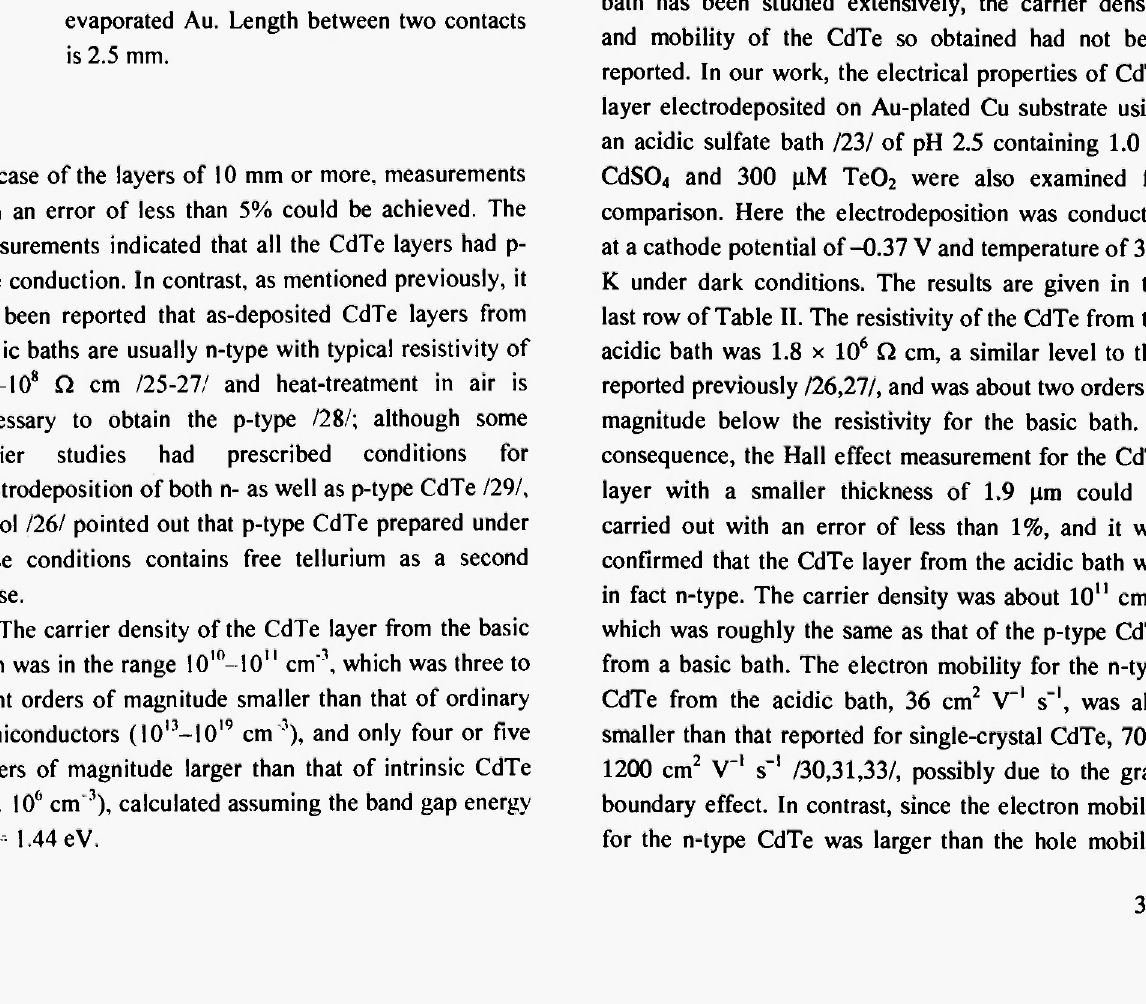
Fig. 12: I-V characteristics for transferred CdTe layers with four different thicknesses: 5, 10, 20, and 30 μητι. CdTe layers were electrodeposited from ammoniacal electrolyte (40 iriM Cd(ll), 10 mM Te(IV), [NH 3 ] tota , = 5.0 M, pH 10.7, 343 K) at -0.70 V v.*. SHE under illumination. Contact material is evaporated Au. Length between two contacts is 2.5